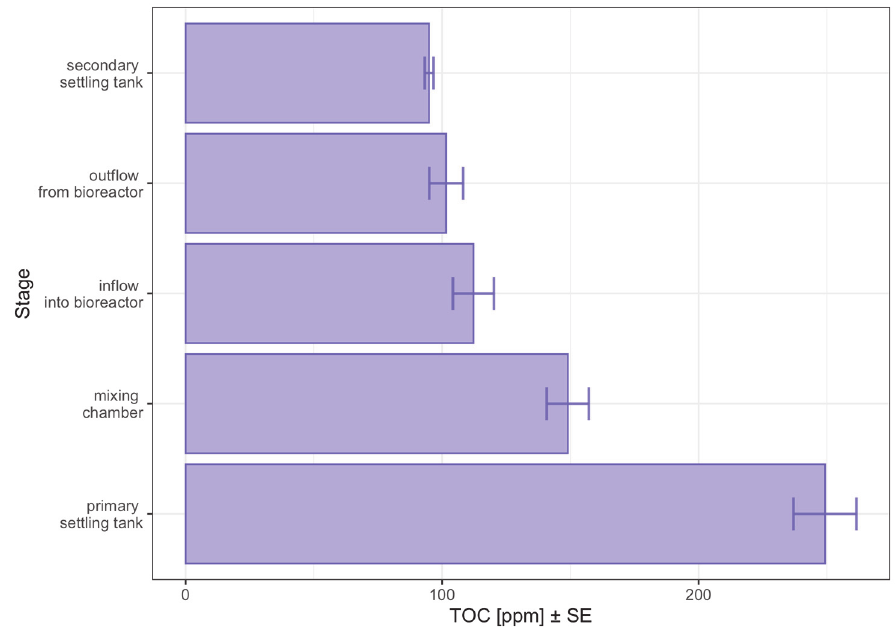
Figure 8. Graph of total organic carbon (TOC) values in the samples tested broken down by the